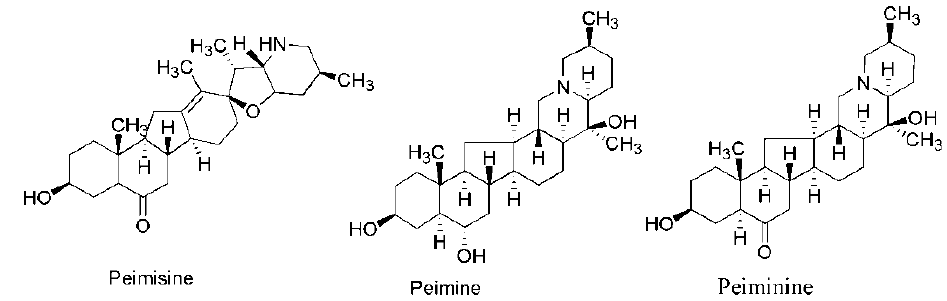
Figure 1. Chemical structure of peimisine, peimine and peiminine.